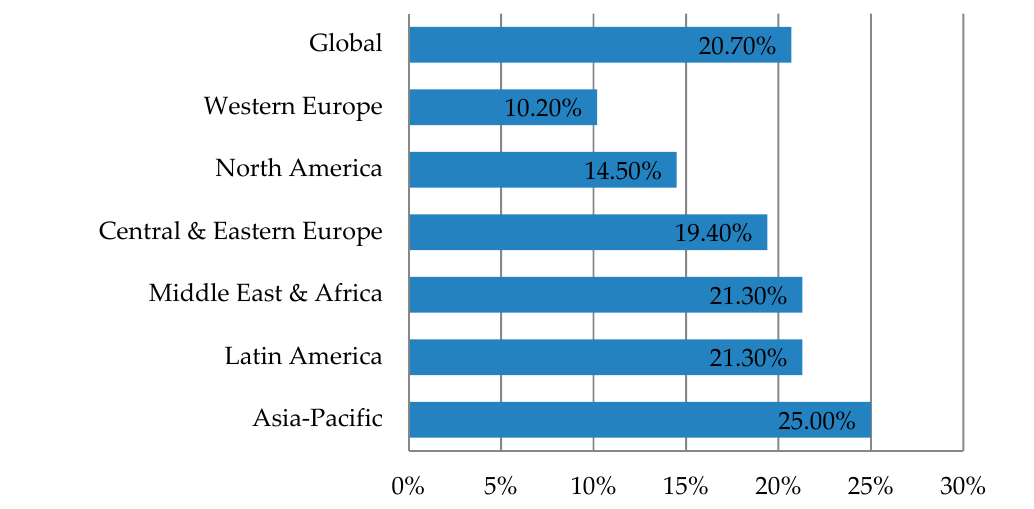
Figure 4. Forecast of global growth in retail e ‐ commerce in 2020 by region. Six of the 10 fastest ‐ growing e ‐ commerce countries in 2019 are from Asia Pacific, led by India and the Philippines with over 30% growth, along with the aggregate growth from China, Malaysia, Indonesia and South Korea. Latin America boasts the fastest growing e ‐ commerce market, with Mexico at 35.0% and Argentina ranking 8th. More mature e ‐ commerce regions such as North America (Canada, 21.1% growth) and Europe (Russia, 18.7% growth) ranked in the Top 10 (Figure 5).